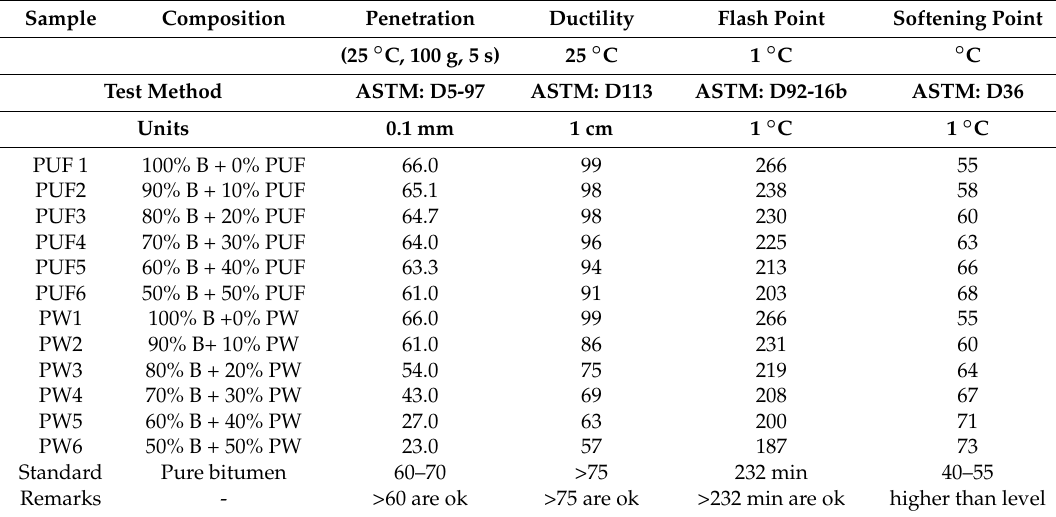
Table 4. Physical properties of